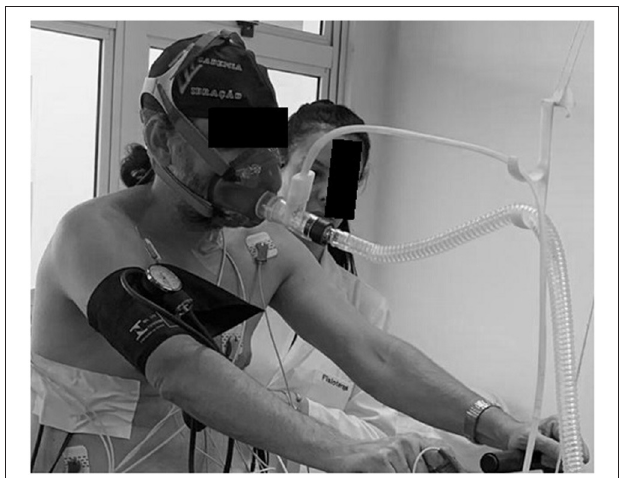
FIGURE 1 | Protocol of our ventilation study adapted with the gas analysis measured breath-by-breath in which the trachea was connected with the pneumotach.